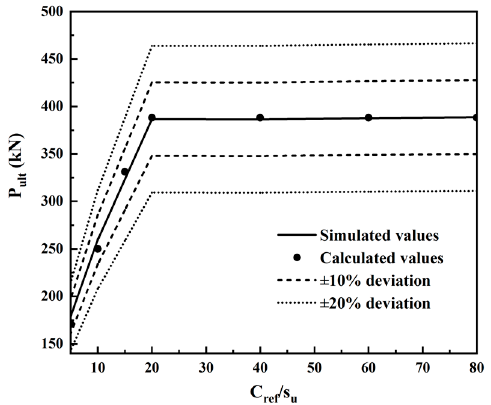
Figure 11. Comparison of simulation results with theoretically calculated values .